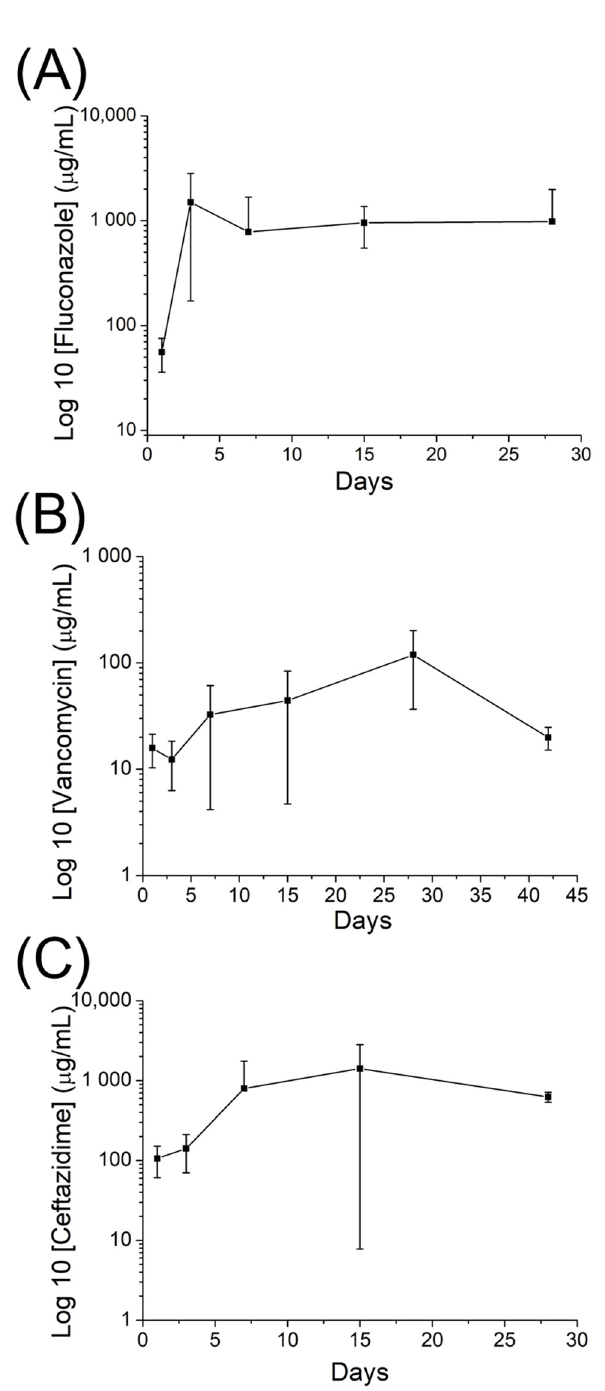
Figure 7. In vivo drug concentrations of ( A ) fluconazole, ( B ) vancomycin, and ( C ) ceftazidime from the nanofibers (the minimum inhibitory concentrations of fluconazole, vancomycin, and ceftazidime are 0.5, 1.0, and 2.0 μ g/mL, respectively).